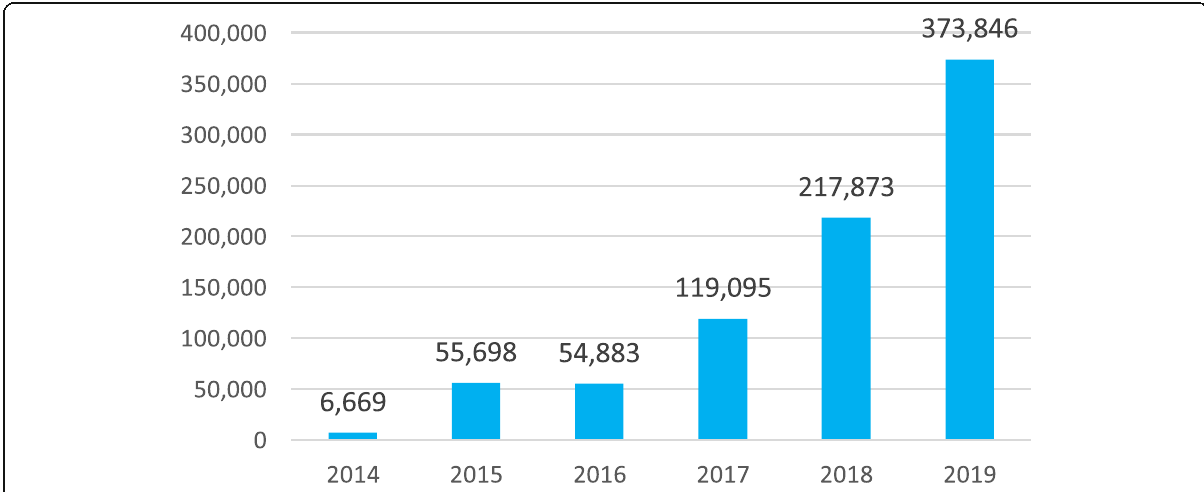
Fig. 2 Number of access* by calendar year (Source: Springer). (Note *: Accesses are defined as the number of times full text or PDF versions of articles are accessed directly from the journal website and SpringerLink. Downloads are defined as HTML, LookInside, PDF, and Epub click.